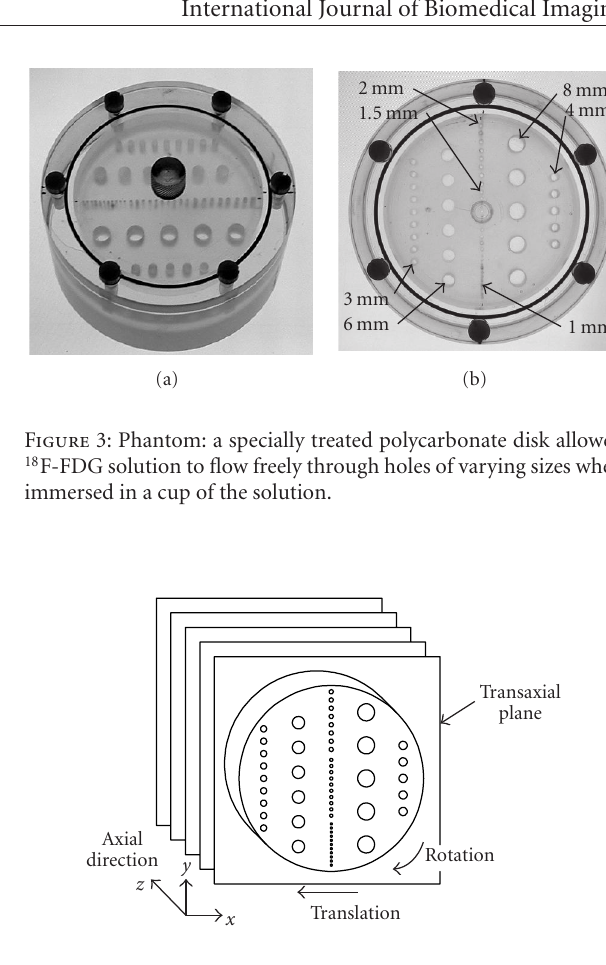
Figure 4: Geometry of phantom orientation for the 3D brain-mode PET acquisition. The phantom disk was aligned with the transaxial plane and translated and rotated within that plane between each of four separate